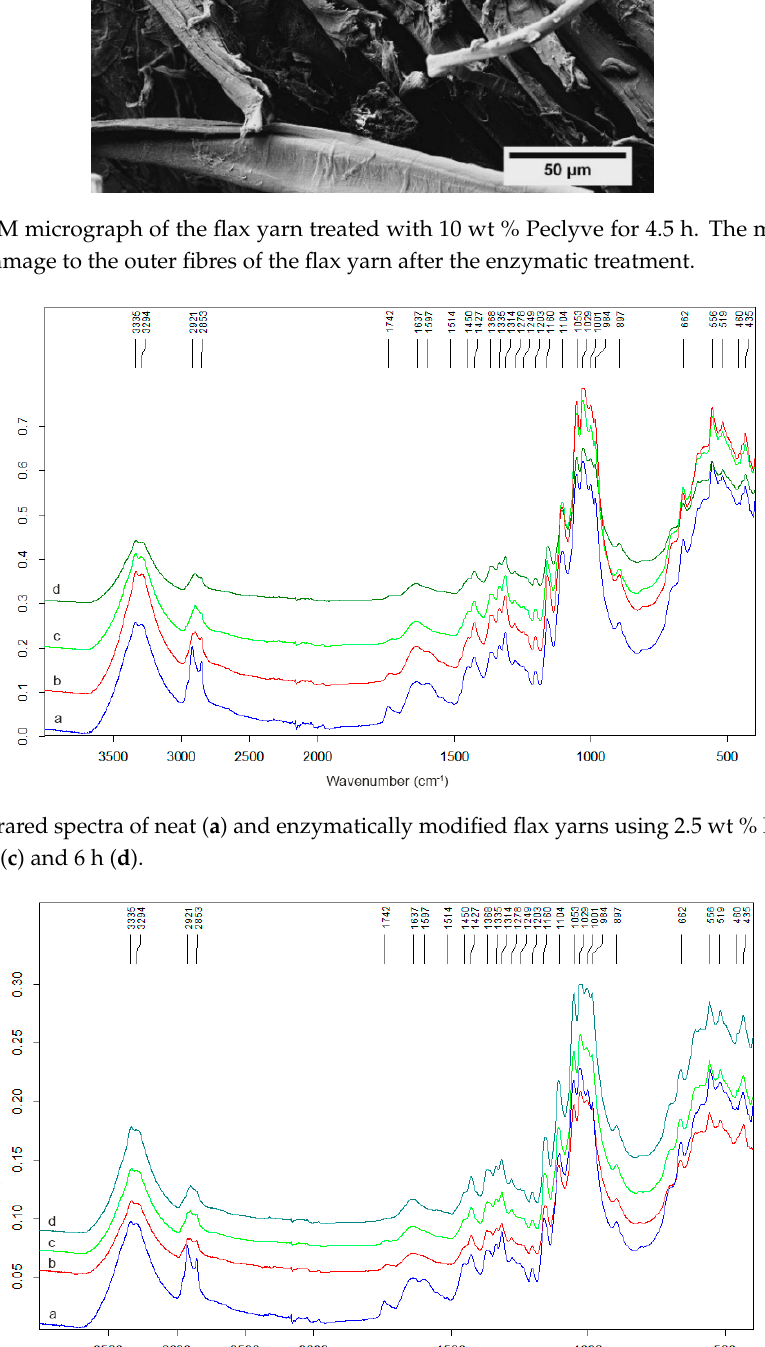
Figure 4. SEM micrograph of the flax yarn treated with 10 wt % Peclyve for 4.5 h. The micrograph shows the damage to the outer fibres of the flax yarn after the enzymatic treatment.